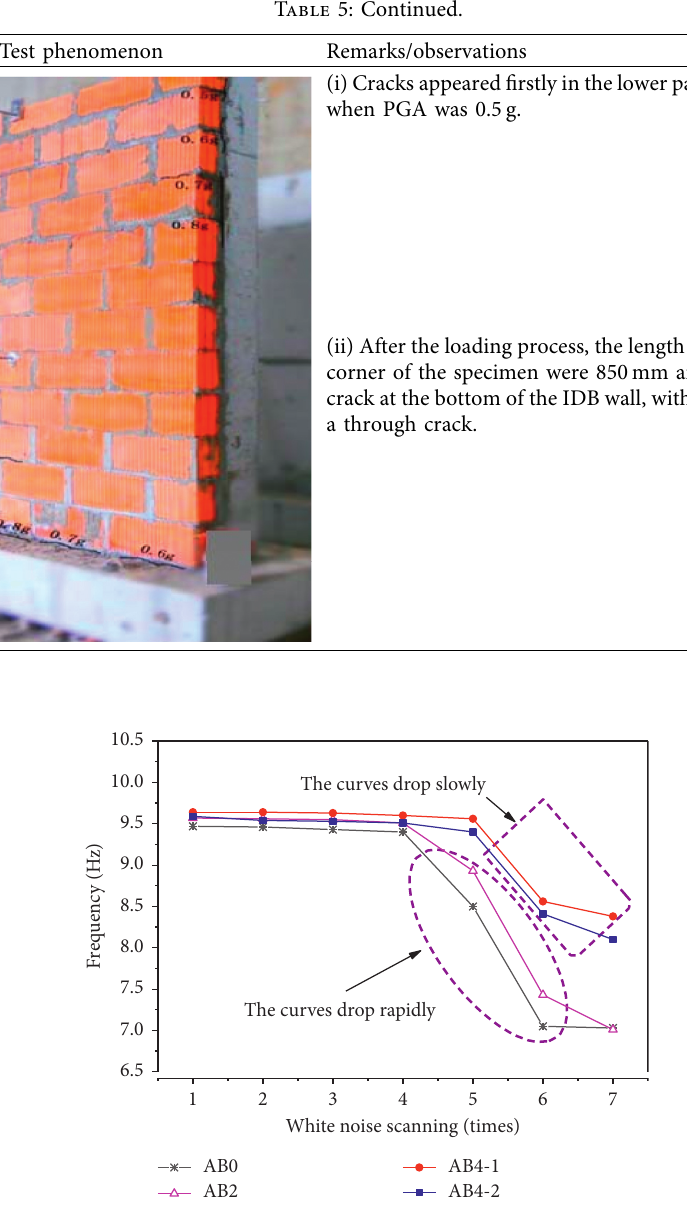
Figure 9: Natural frequency of the